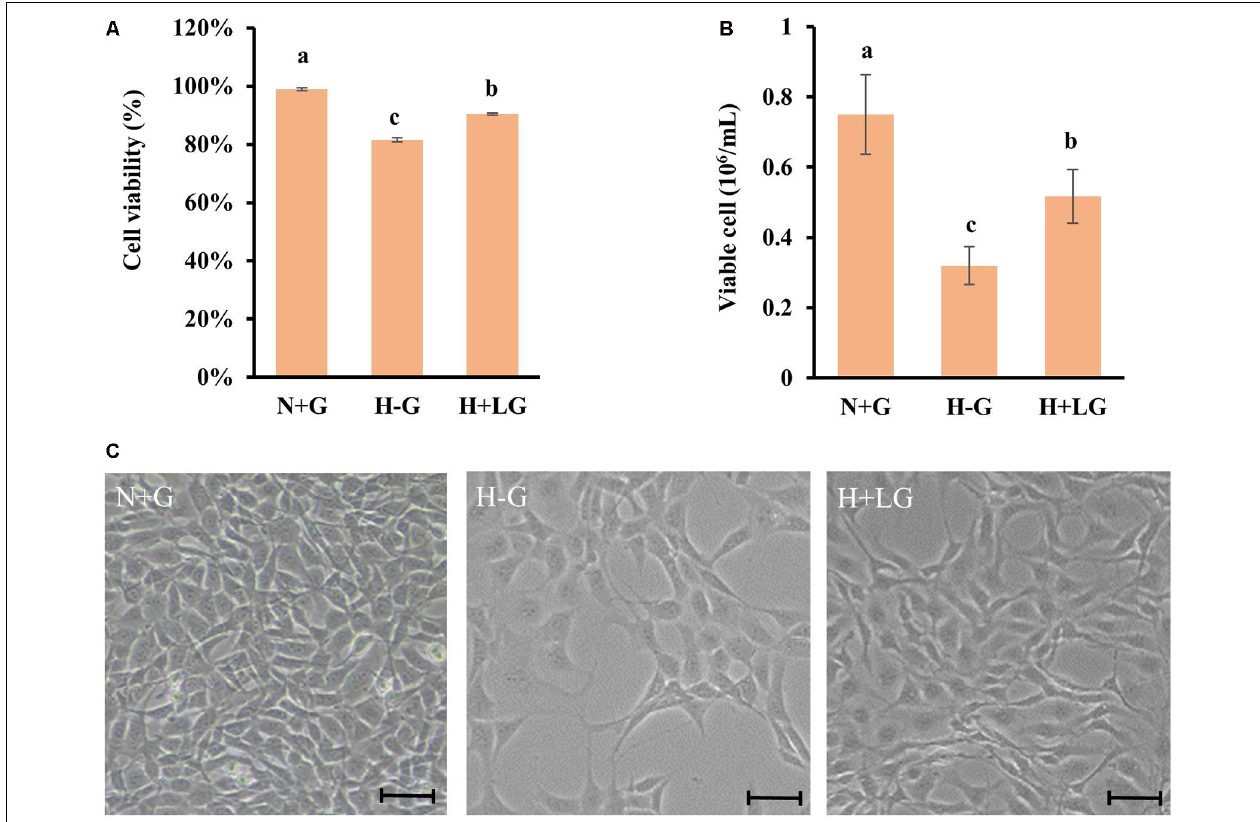
FIGURE 3 | HT22 cells under N+G, H − G, and H+LG for 17.5 h. Cell viability (A) and viable cell number (B) were plotted as the average of three independent experiments ± SD. One-way ANOVA followed by Fisher’s least significant difference for multiple comparisons was used for statistical analysis. Different letters labeled represent significant differences at p < 0.05 level among treatments. Images of cell density and morphology (C) were recorded under a Nikon Eclipse Ts2 Inverted Routine Microscope. Scale bar = 100 µ